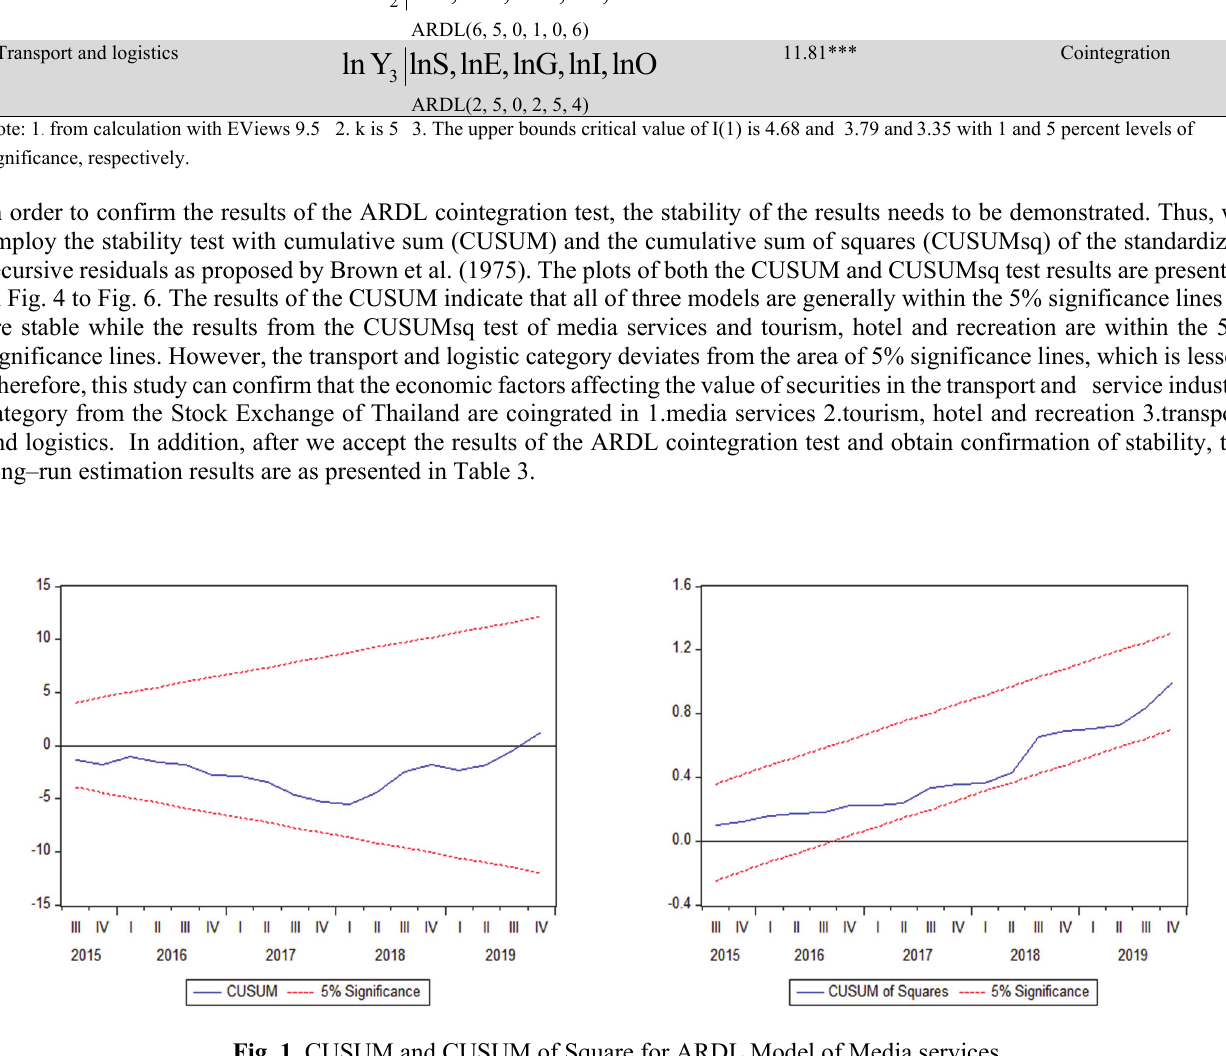
Fig. 1. CUSUM and CUSUM of Square for ARDL Model of Media